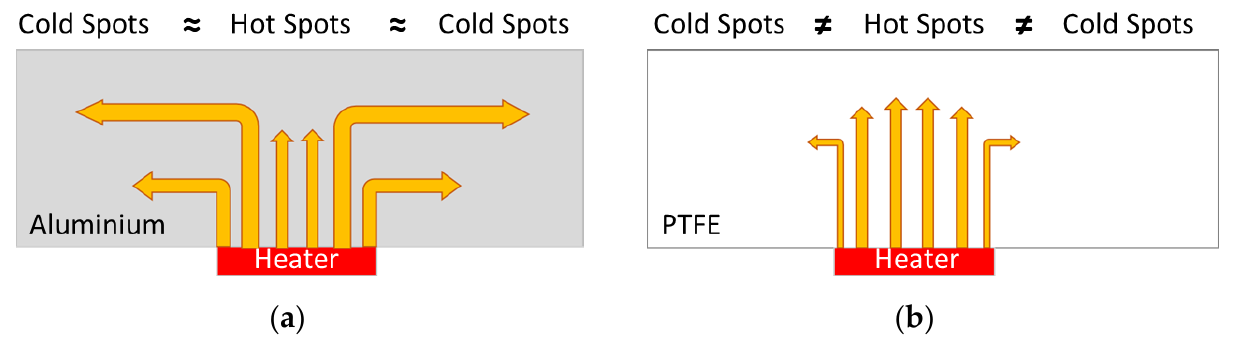
Figure 15. Thermal diffusion schemes of AA6061 ( a ) and PTFE ( b ). Yellow arrows illustrate the heat transference along the materials surfaces.